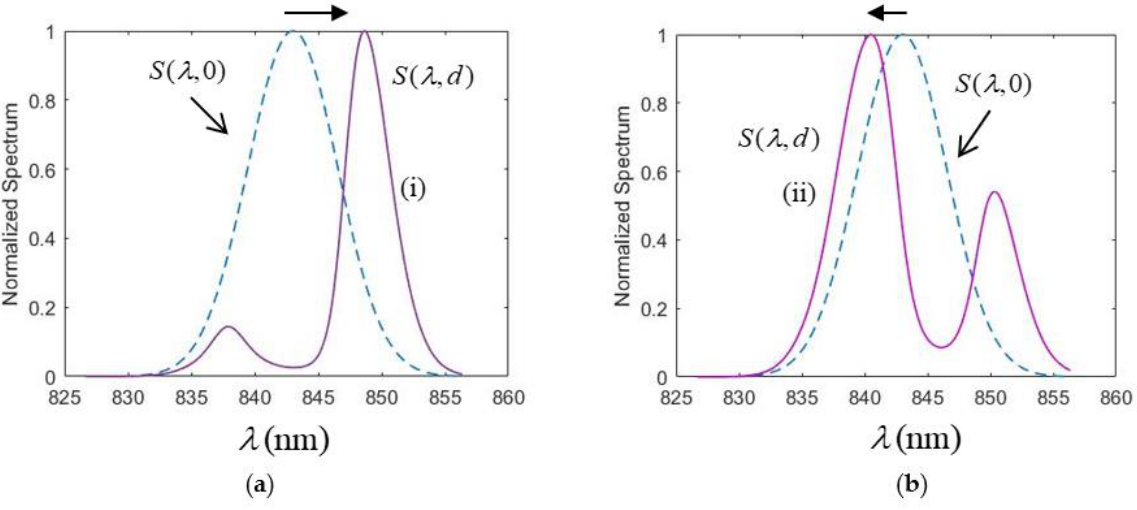
Figure 7. The normalized spectral distribution ( , ) Sd  of a unit Gaussian spectrum in Figure 6. ( a ) Red shift for V = 1.6 × 10 4 V/cm. ( b ) Blue shift for V = 10 5 V/cm. ( a ) Red shift for V = 1.6 × 10 4 V/cm. ( b ) Blue shift for V = 10 5 V/cm. (i) 1.6 × 10 4 V/cm and (ii) 10 5